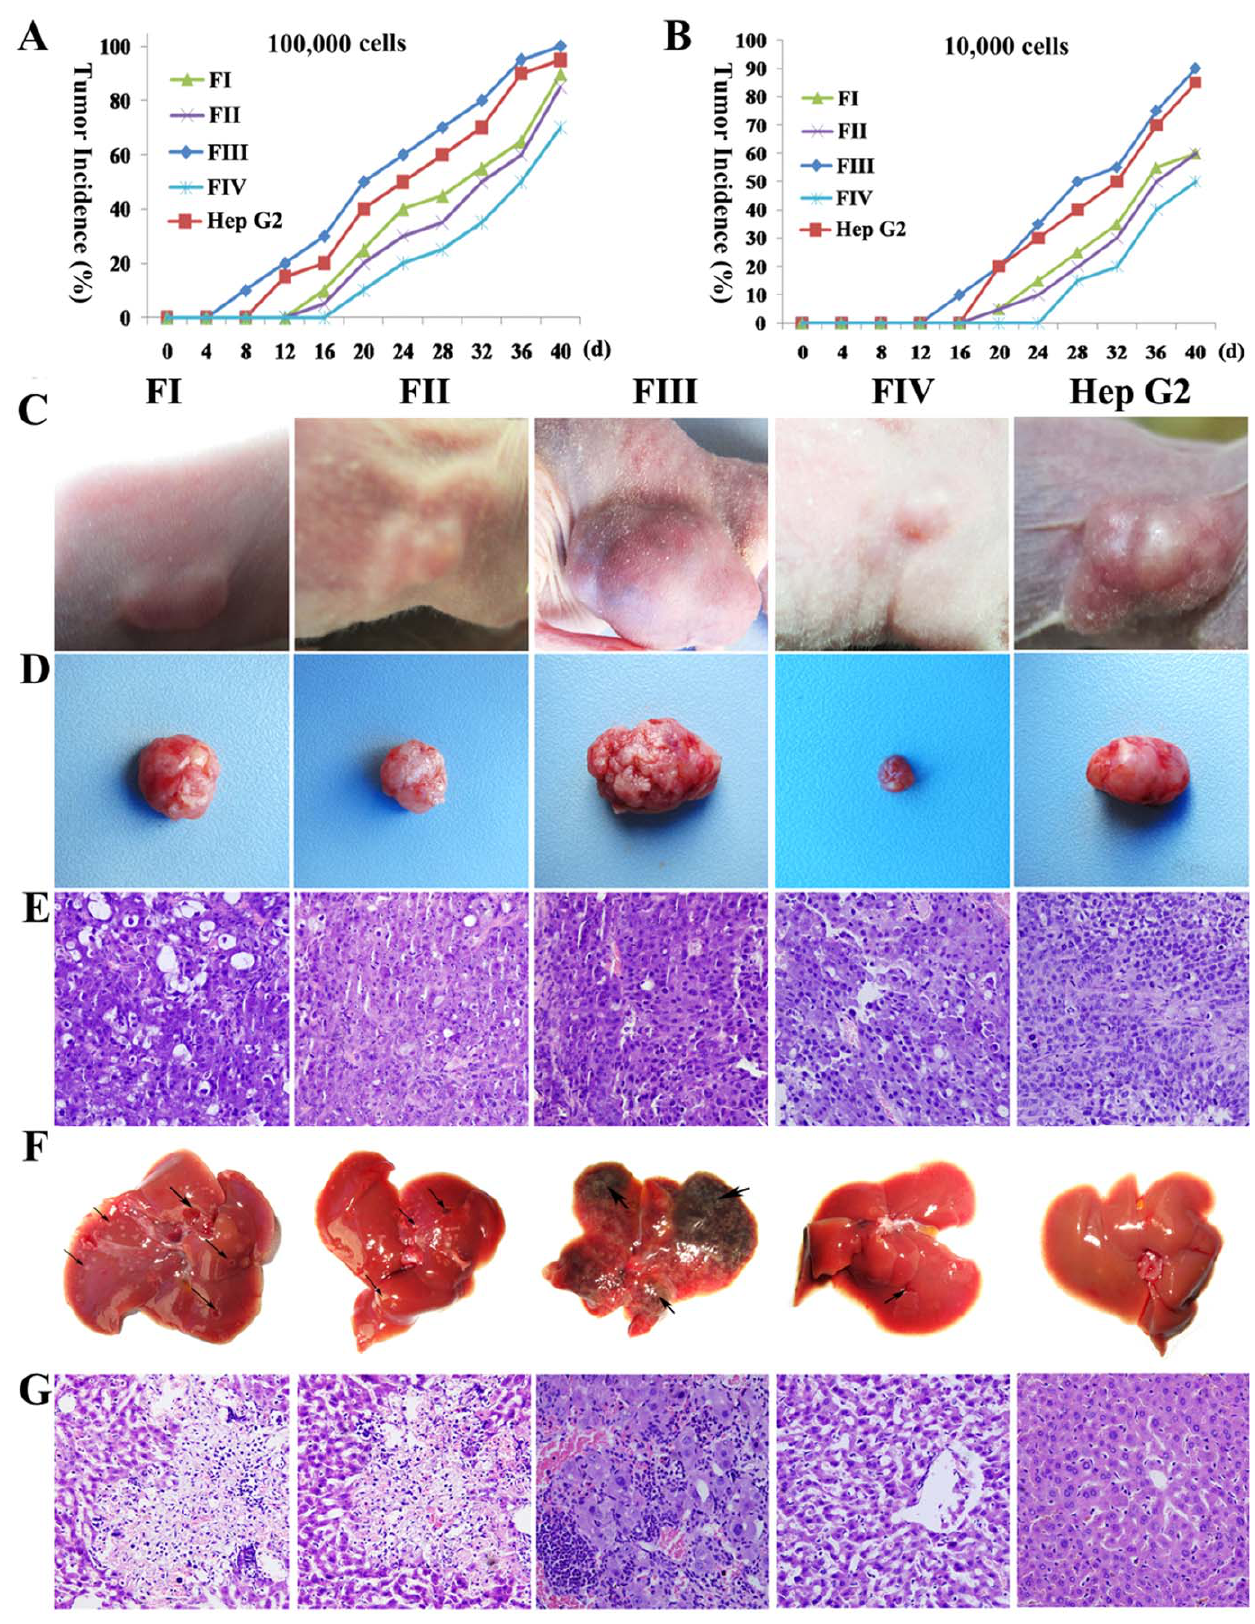
Figure 6. Tumorigenic and invasive potential of cells from each fraction. (A) Column chart showing the tumor incidence in each group following the injection of 1 6 10 5 cells. (B) Column chart showing the tumor incidence in each group following the injection of 1 6 10 4 cells. (C)